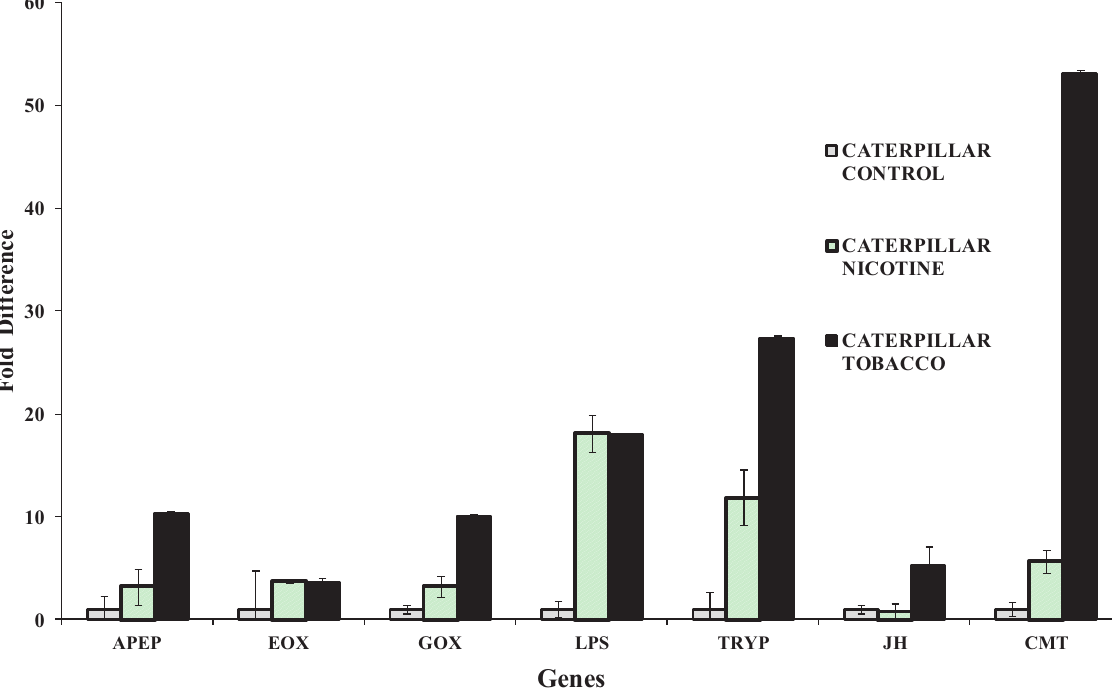
Figure 5. Relative fold changes (y-axis) of gene expression of caterpillars that fed on artificial diet (control) compared to caterpillars that fed on artificial diet treated with nicotine (nicotine) and caterpillars that fed on tobacco plants (tobacco). The altered expression of the genes of interest include aminopeptidase (APEP), ecdysone oxidase (EOX), glucose oxidase (GOX), lipase (LPS), trypsin (TRYP), juvenile hormone inducible protein (JH) and chymotrypsin (CMT). Bars indicate means ± Standard Error and N = 4 biological replicates. Different letters indicate significance with ANOVA and Fisher’s LSD at p <